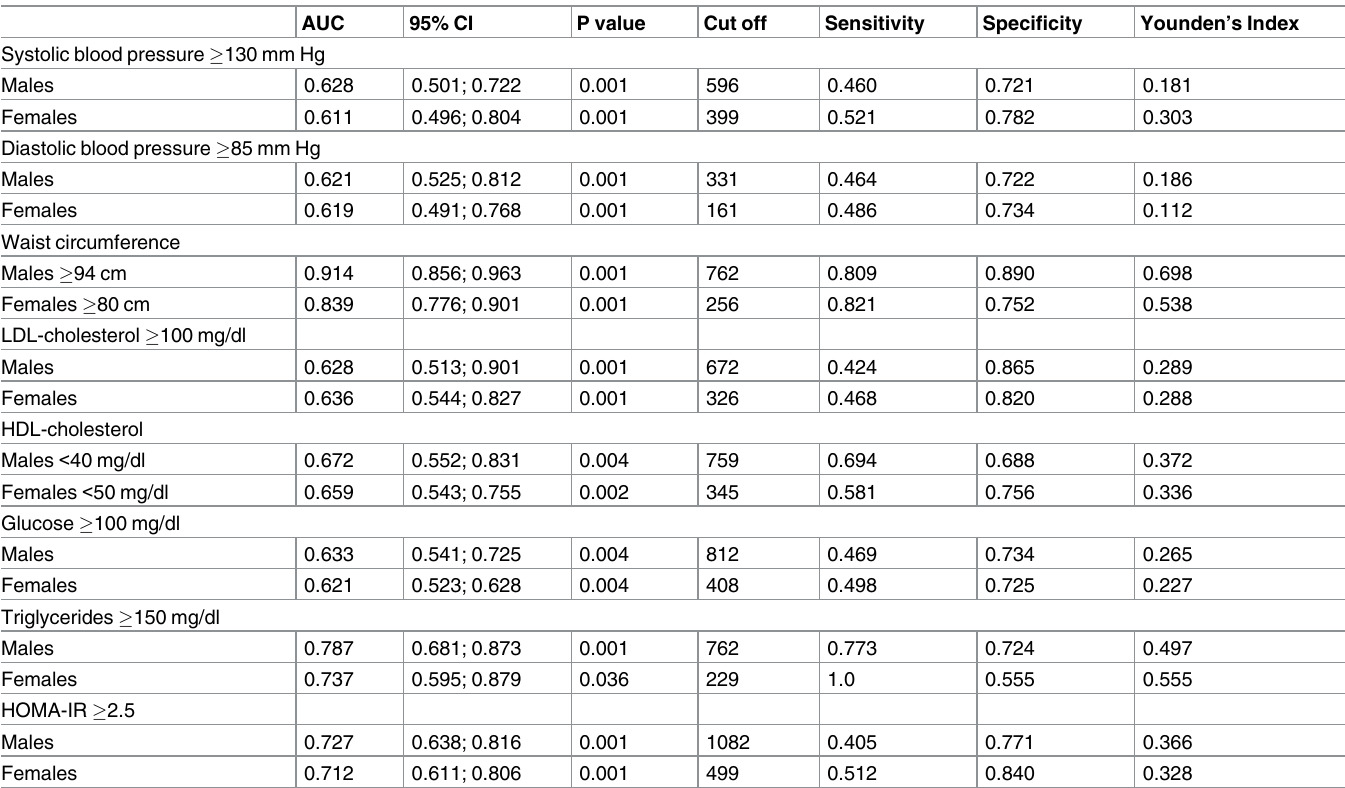
Table 4. AUC values and cut-off points for VAT volume by gender.